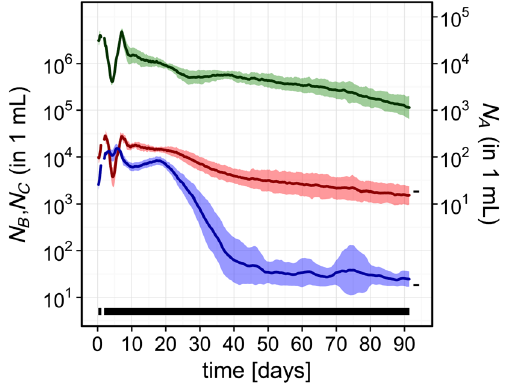
FIG. 6. Effect of pH buffer. Time series for nine CES measured by holography with the Tris-acetate pH buffer omitted from the medium. Geometric mean and standard deviation are shown as in Figs. 1(c) –